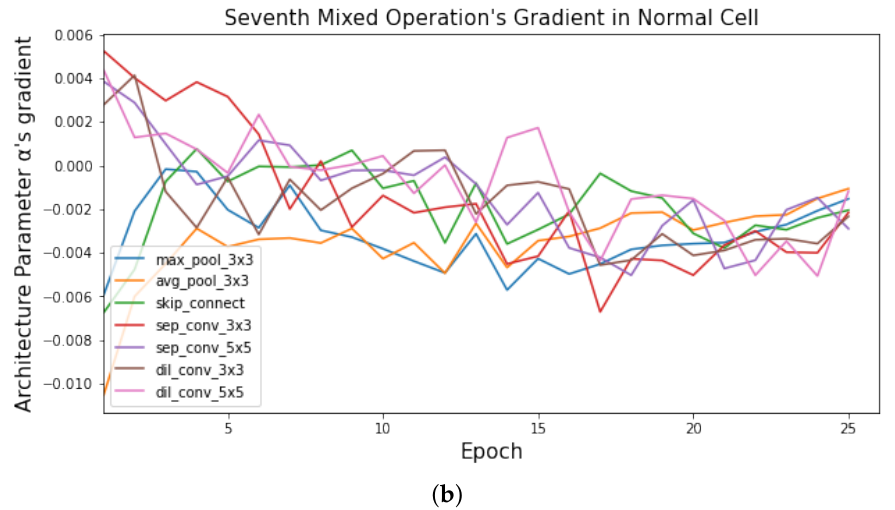
Figure 4. Seventh mixed operation over stage 1 epoch. ( a ) Architecture parameter. ( b ) Gradient of the architecture